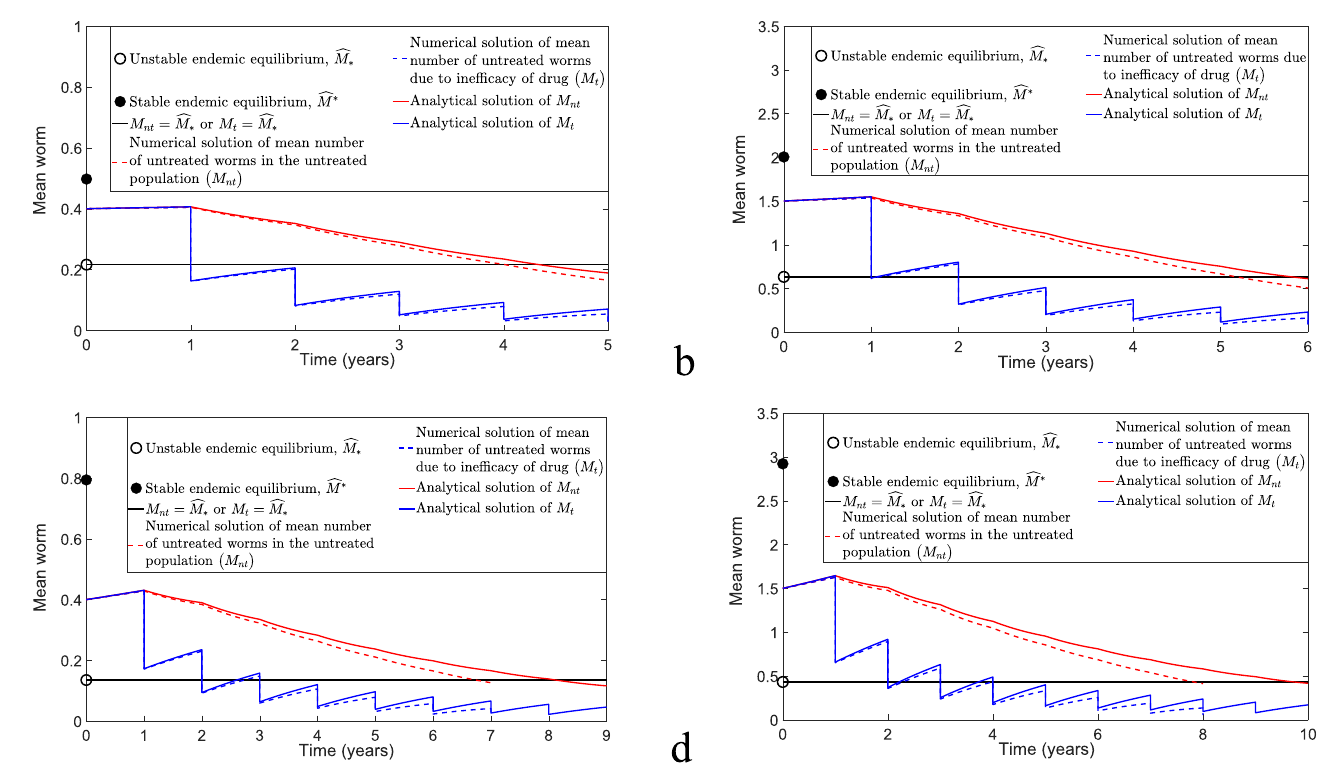
Fig 9. Numerical comparison of model (12) and (13) and model (9) and (10) for annual MDA with � = ω = 0.6 and varying k and R 0 values. (a) k = 0.05, R 0 = 1.8 and M are 1.4241 × 10 − 4 and 4.9371 × 10 − 5 , respectively. (b) k = 0.2, R 0 = 1.8 and MSE for M and MSE for M nt t (c) k = 0.05, R 0 = 2 and MSE for M nt and M t are 4.3739 × 10 − 4 and 1.1943 × 10 − 4 , respectively. (d) k = 0.2, R 0 = 2 and MSE for M nt and M t are 8.6585 × 10 − 3 and 2.1309 × 10 − 3 ,